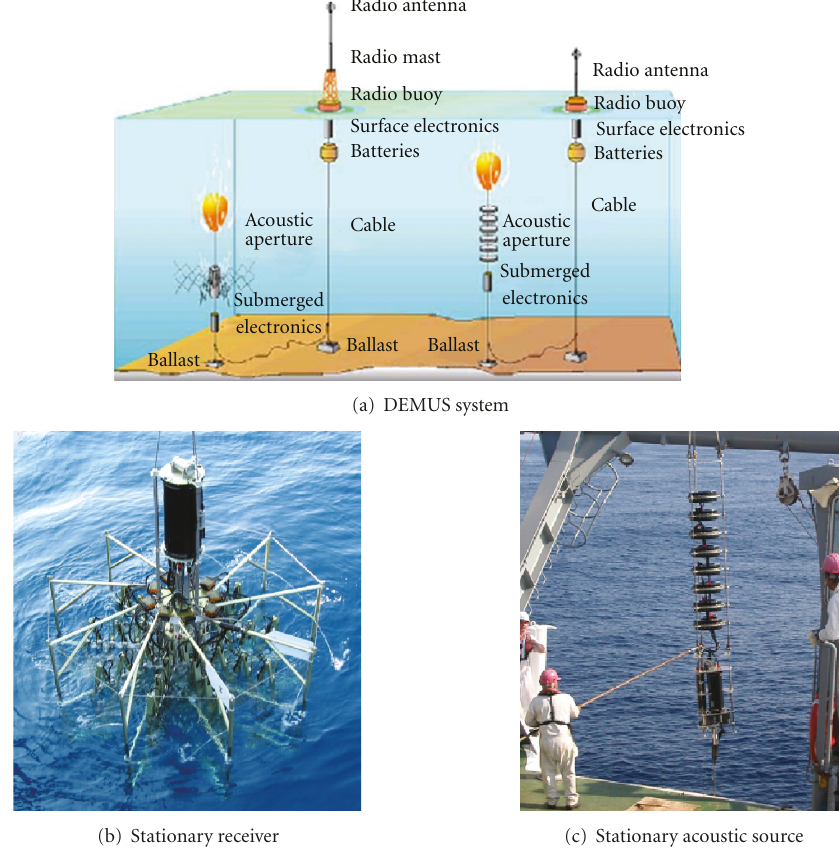
Figure 1: Illustration of a stationary multistatic sonar system (a). A prototype of a stationary receiving system is shown in (b). As an acoustic source, the stationary system shown in (c) has been used. The system with three receivers and the source is called DEMUS. See [7, 8] for further